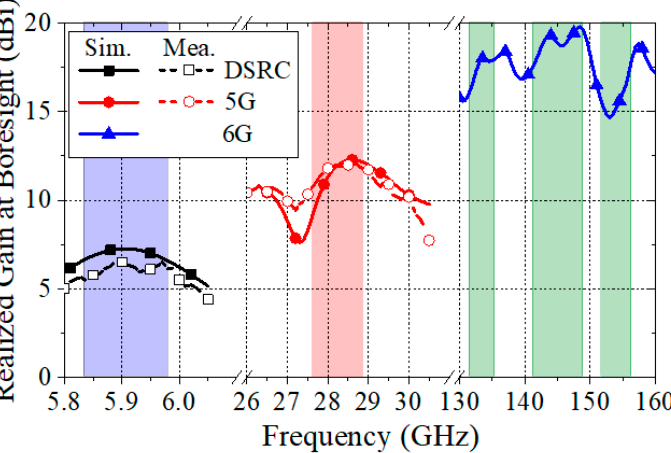
Figure 17. Simulated and measured frequency-dependent peak realized gain at the boresight. The simulated and measured E-plane normalized radiation patterns of the designed antenna at 5.9 GHz, 28 GHz, and 154.5 GHz are shown in Figure 18. Broadside